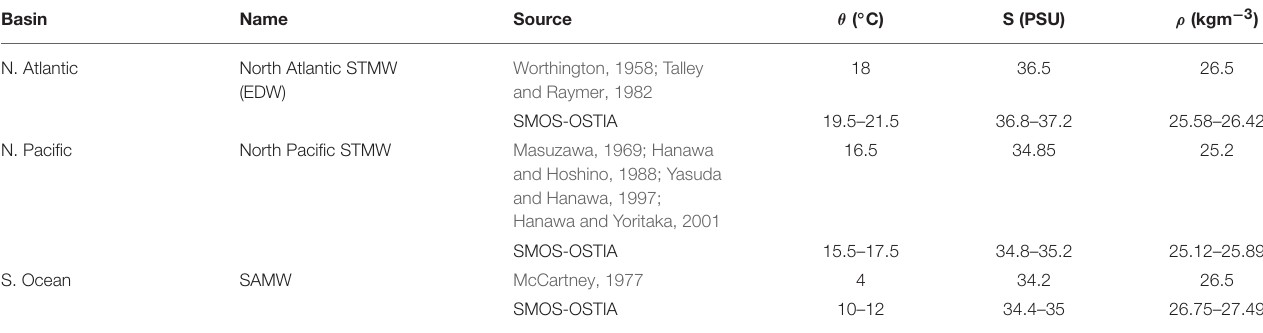
TABLE 1 | Characteristic temperatures, salinities, and densities of Mode Waters in the North Atlantic, North Pacific, and Southern Ocean found in literature using in-situ data.